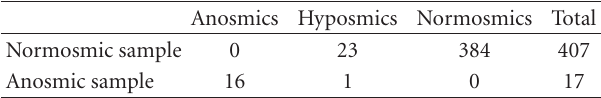
Table 6: Classification of the population resulting from the cuto ff criteria.